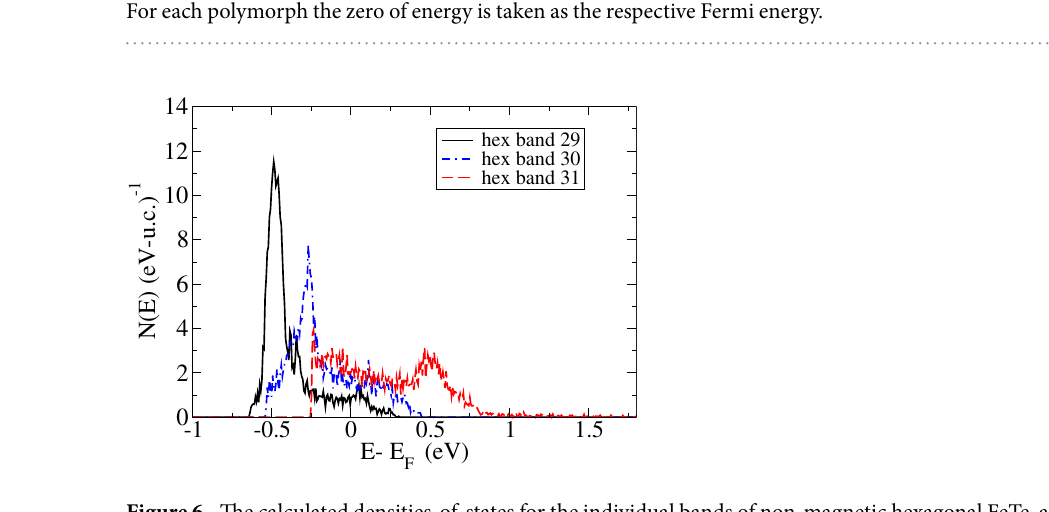
Figure 6. The calculated densities-of-states for the individual bands of non-magnetic hexagonal FeTe, as indicated. The tetragonal results are not